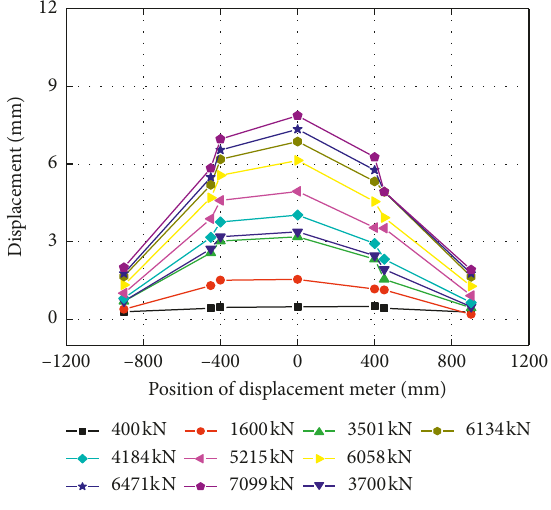
Figure 14: The deformation of J-3.